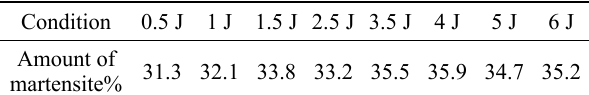
Table 2 The amount of martensite on worn surfaces. Condition